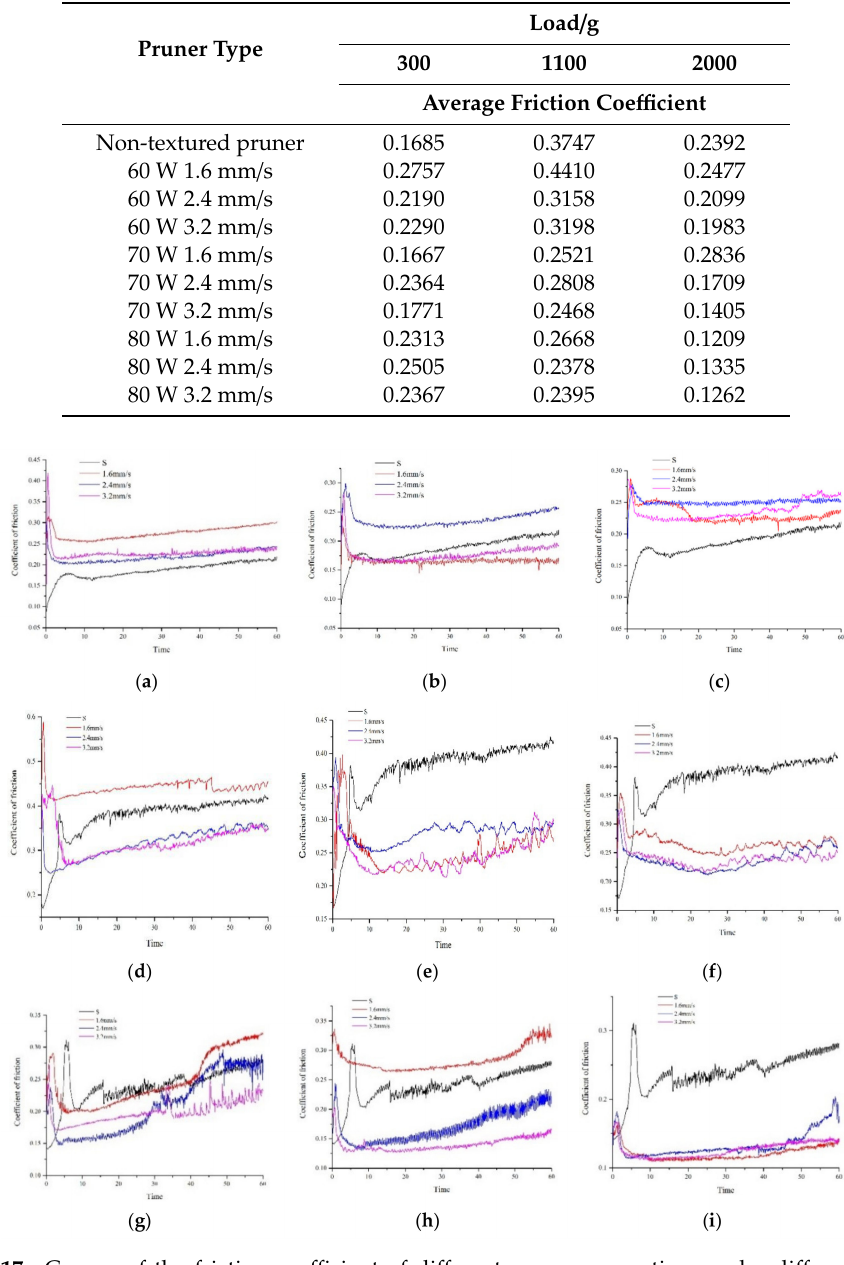
Table 7. Average friction coe ffi cients of all factor tests under di ff erent loads.